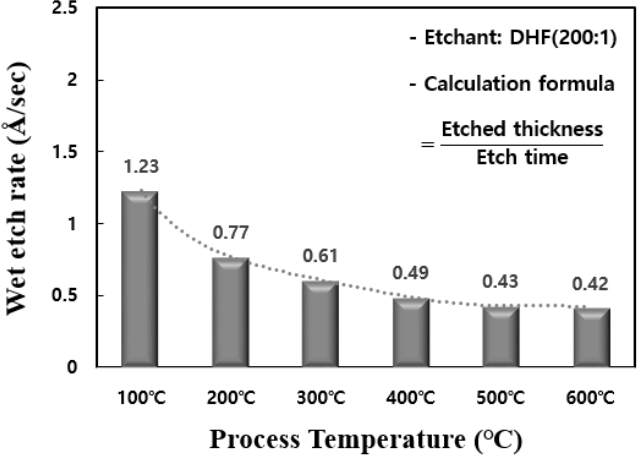
Figure 2. Wet etch rate characteristics of SiO 2 thin film at various process temperatures.